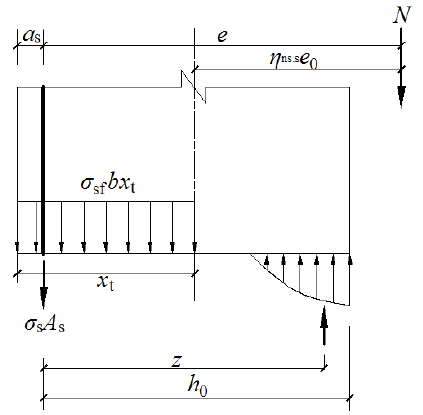
Figure 13. The equilibrium of forces on the normal section of the column.